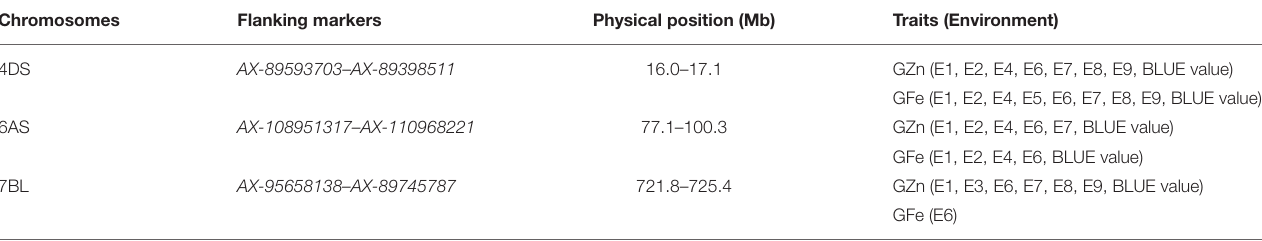
TABLE 5 | Chromosomal intervals for GZn and GFe identified by multi-trait composite interval mapping (MCIM). Chromosomes